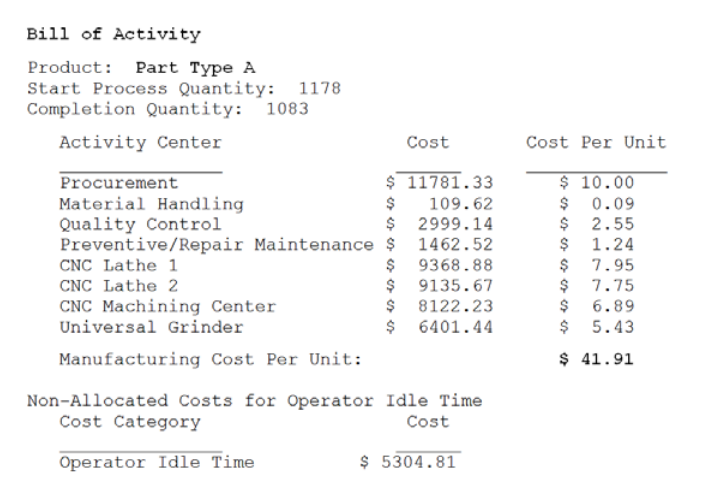
Figure 3. “Part family bill of activity with non-allocated costs”.